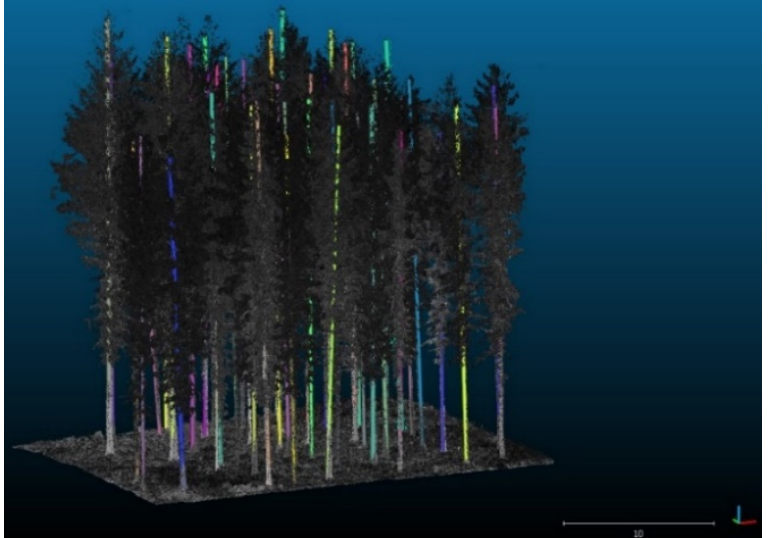
Figure 3. Scalar field color view of the study area, stem segmentation, and cylinder fitting using the random sample consensus (RANSAC) method.